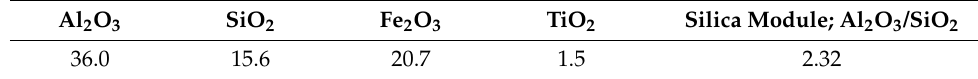
Table 3. The chemical composition of bauxite, %.